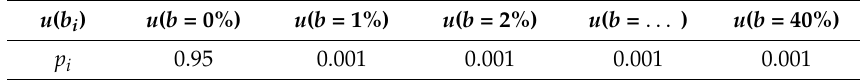
Table 7. The probability values of disruptions in the operation of the S 2 network corresponding to the b discount on the first level.